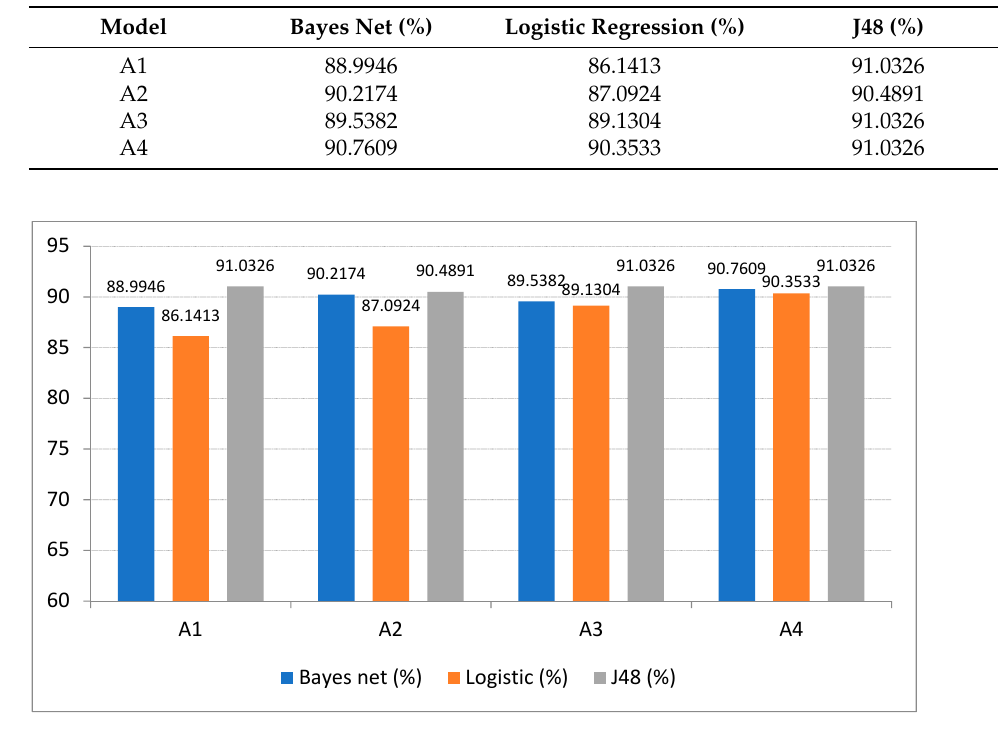
Figure 3. Models A1-A4 net profit decision (statistical graph). Results of Experiment 1: Bayes net classifier: Model A4 has the highest accuracy of 90.7609%, and Model A1